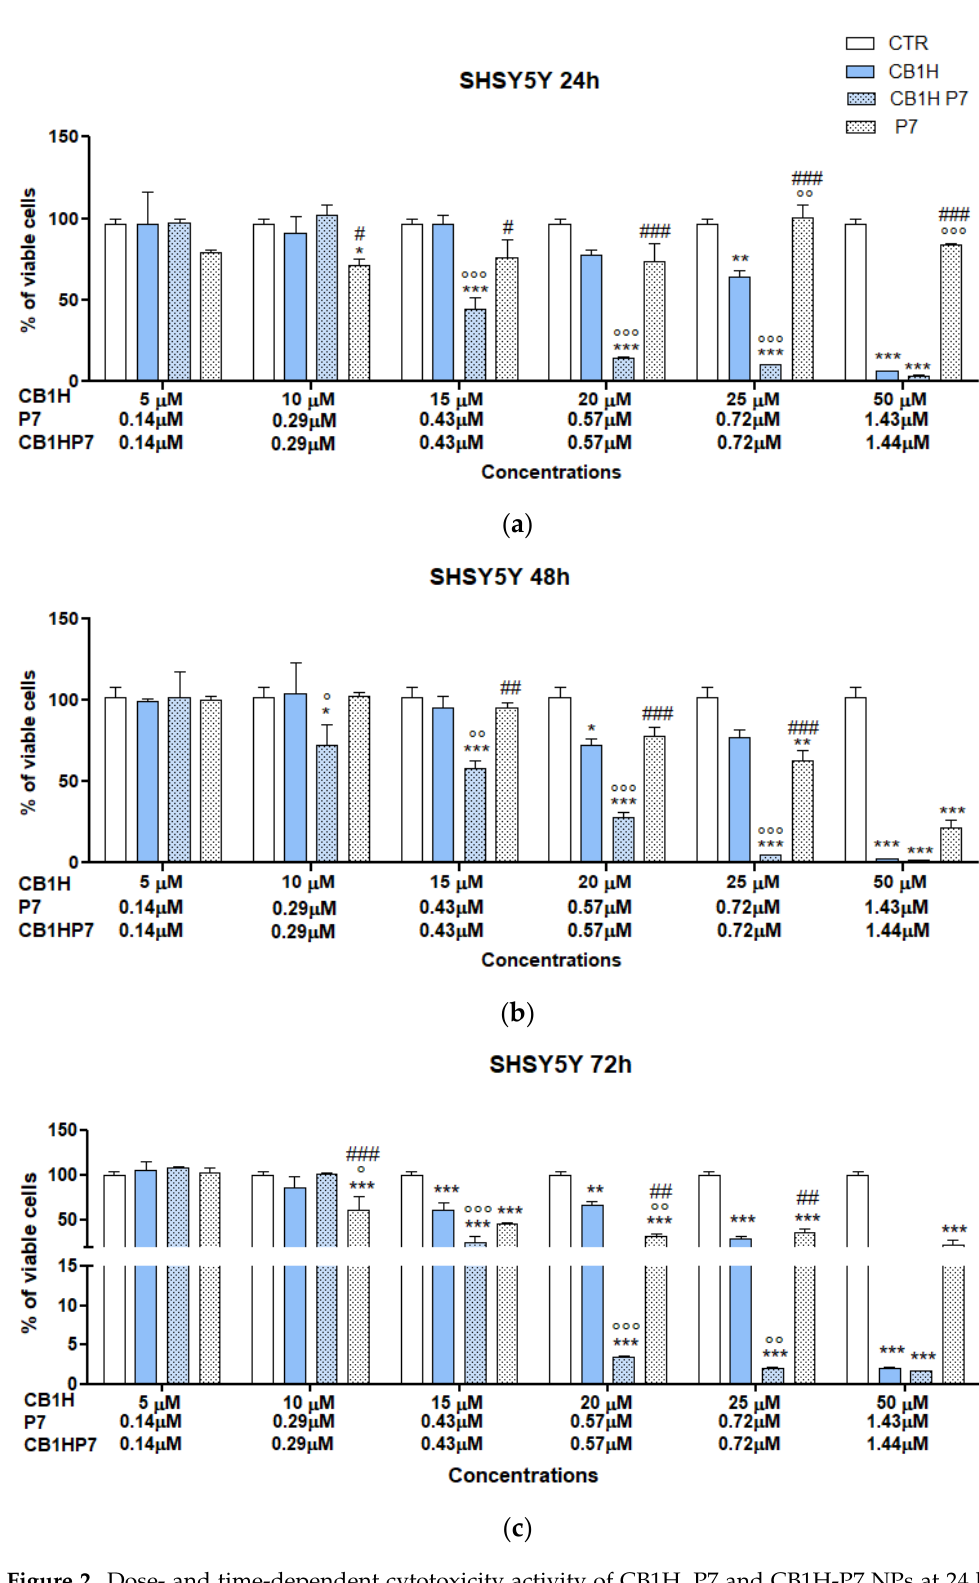
Figure 2. Dose- and time-dependent cytotoxicity activity of CB1H, P7 and CB1H-P7 NPs at 24 h ( a ), 48 h ( b ), and 72 h ( c ) towards SHSY 5Y cells. Significance refers to control (*), CB1H (°), or CB1H-P7 (#). Specifically, p > 0.05 ns; p < 0.05 * (vs. CTR), ° (vs. CB1H), # (vs. CB1H-P7); p < 0.01 ** (vs. CTR), °° (vs. CB1H), ## (vs. CB1H-P7); p < 0.001 *** (vs. CTR), °°° (vs. CB1H), ### (vs. CB1H-P7). As for IMR-32 cells, except for experiments at 48 h of exposure, P7 caused a signifi- cant reduction in cell viability only at the highest concentration tested (1.43 µM), but only for 24 and 72 h of exposure was cell viability < 50%. At 24 h of exposure, CB1H and CB1H- P7 caused a statistically substantial reduction in cell viability and were significantly more cytotoxic than P7 when administered at concentrations of 10 µM (CB1H) and 0.29 µM